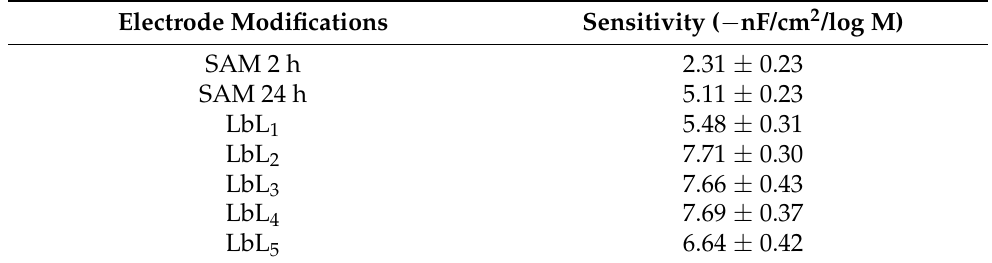
Table 1. Sensitivity of electrodes modified with SAM of TU and layer-by-layer of TU and